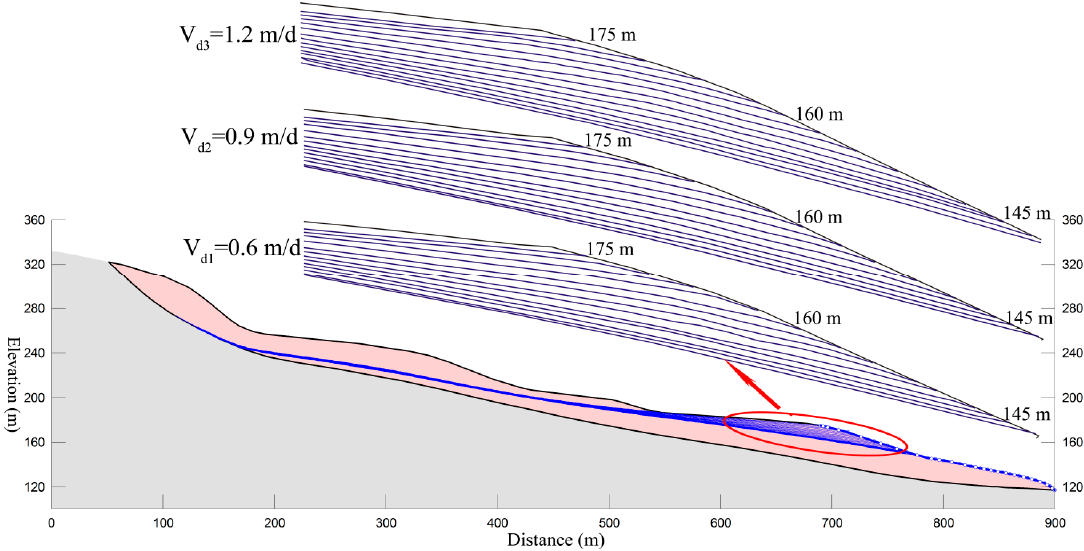
Figure 6. Transient changes under operating conditions 1-1, 1-2 and 1-3.